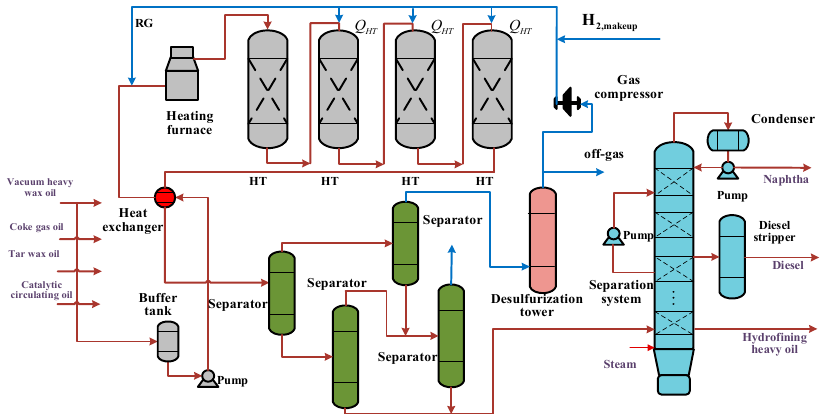
Figure 1. Process flow diagram of the residue hydrogenation unit. (HT: hydrotreater; RG: recycled hydrogen gas).